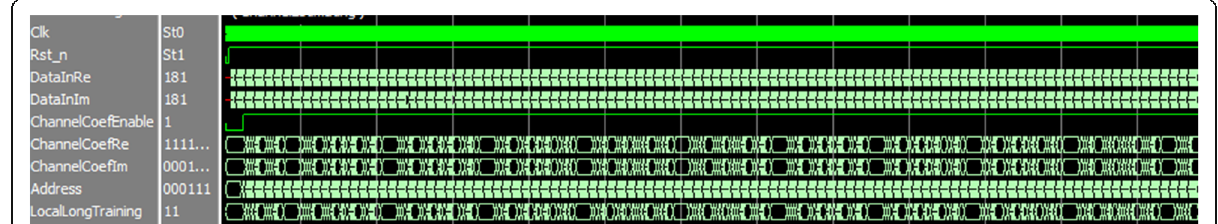
Fig. 8 The simulation diagram of channel estimation. The simulation results of channel estimation. The frequency domain is calculated on the basis of the time domain as part of the channel